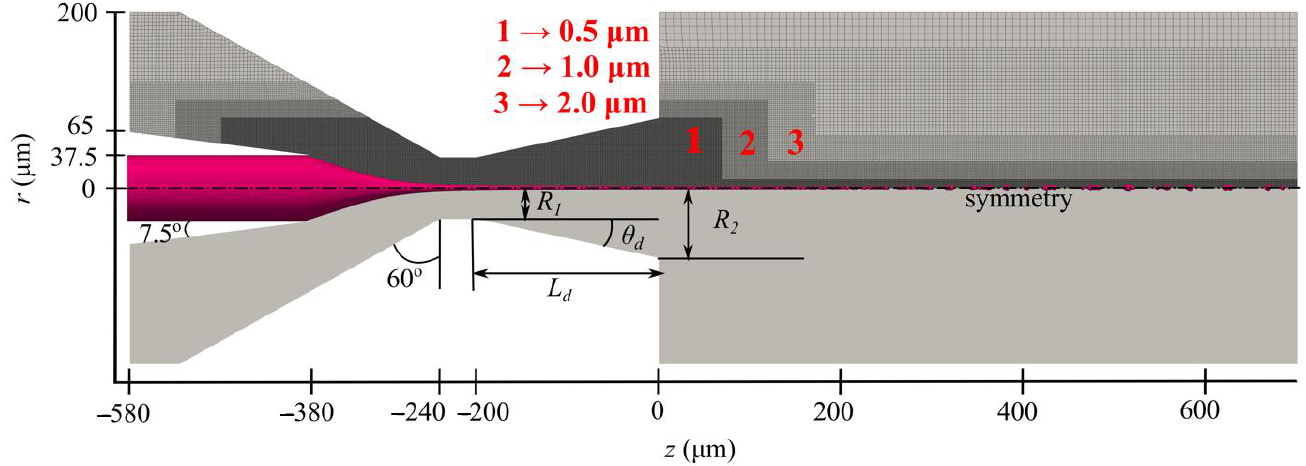
Figure 2. A part of the computational domain of a typical converging–diverging GDVN (below) and its discretization in the vicinity of the nozzle (above). R 1 = 35 µm is the fixed throat radius, R 2 and L d are the outlet radius and the length of the diverging channel, respectively. They are both varied in the present study. The total discretization domain has a radius of 1000 µm and a length of 3200 µm. The numbers 1, 2, and 3 mark the cell size and the areas of the mesh refinement.